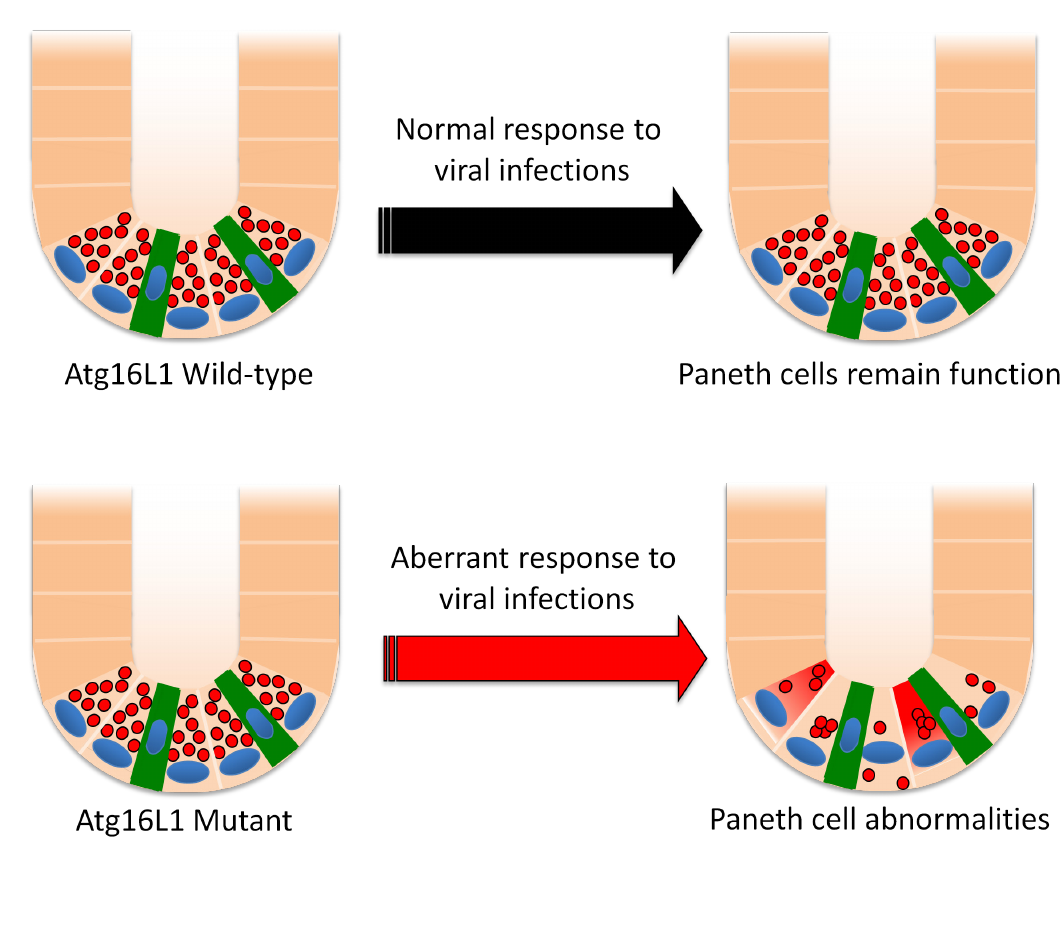
Figure 2. Atg16L1 mutation leads to Paneth cell abnormalities during viral infection. The small intestinal crypt contains several Paneth cells with antimicrobial granules (red circles) and intestinal stem cells (green). The response to murine norovirus (MNV) infection leads to Paneth cell abnormalities specifically in Atg16L1 mutant mice including depletion of granules, aberrant morphology, and altered gene expression. In contrast, MNV does not cause these changes in control